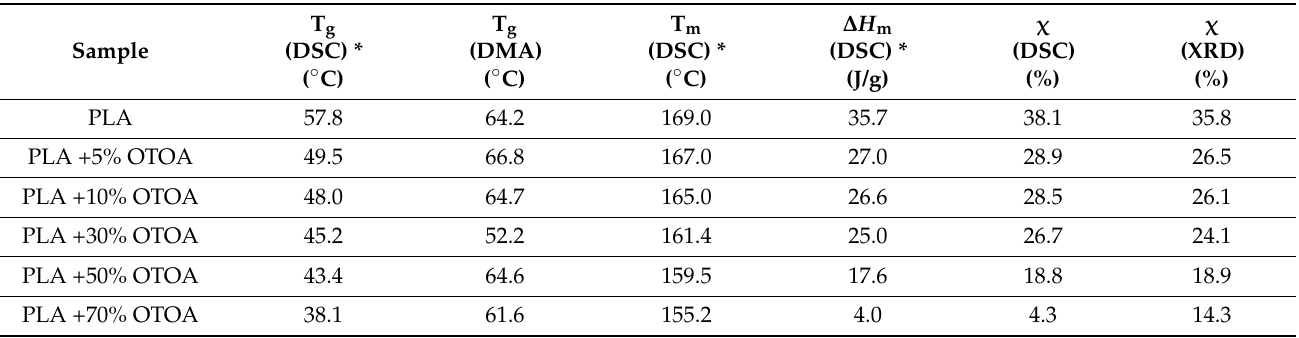
Table 2. Thermodynamic and structural characteristics of PLA + OTOA films (0–70%) obtained using the DSC, DMA and XRD methods.